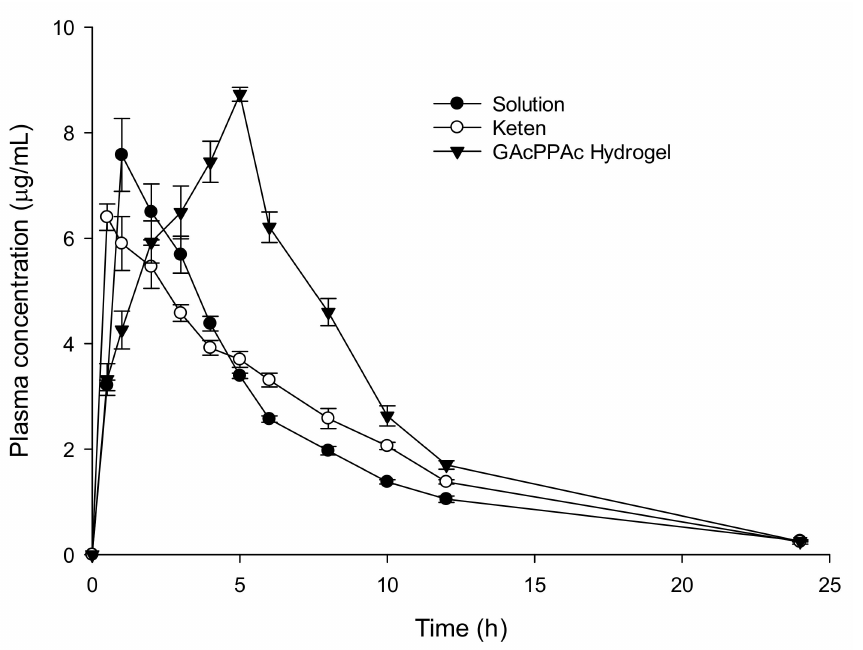
Figure 8. Plasma concentration vs. time plot of KETM administered as the oral solution, keten, and GAcPAA hydrogels to healthy rabbits. ( n =